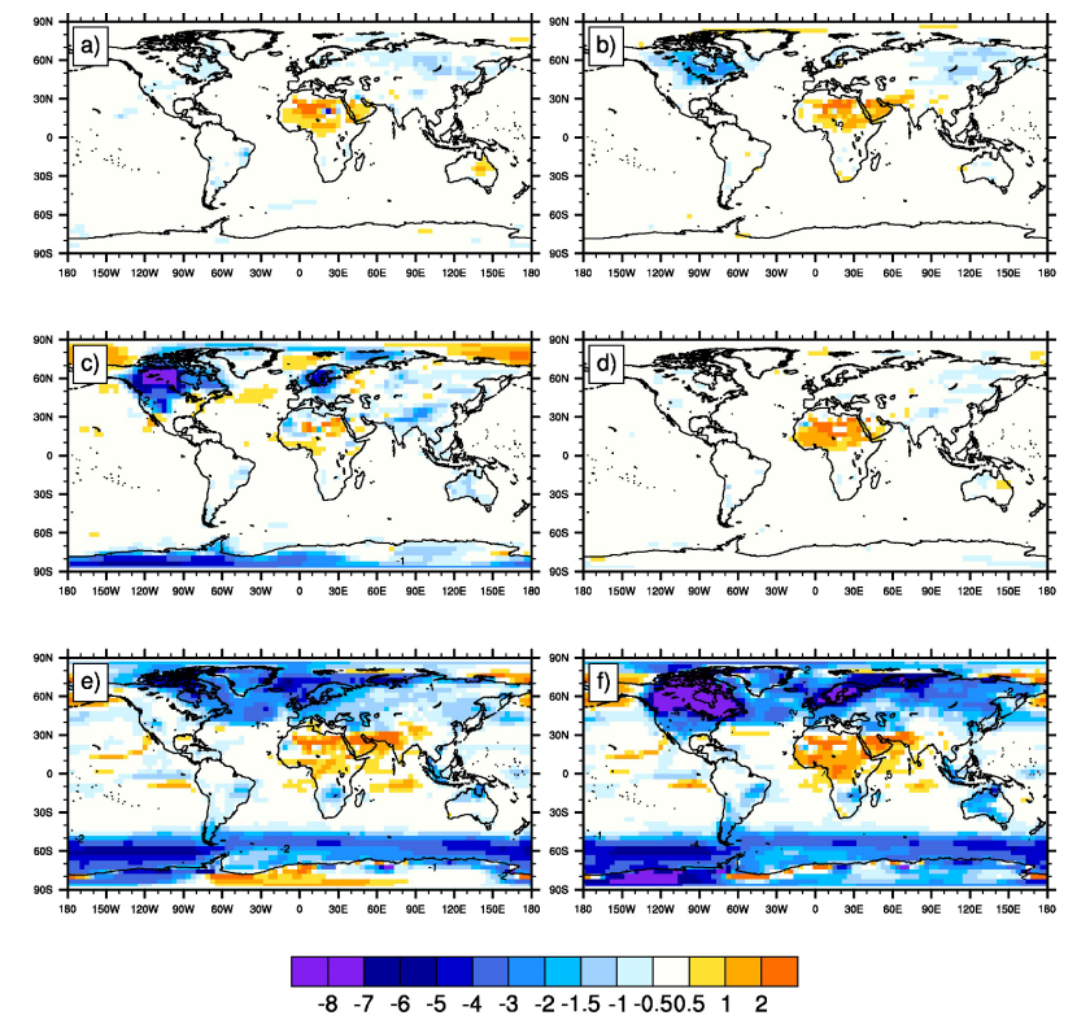
Fig. 4. Annual mean difference of δ 18 O precip (‰) of (a) GHG, (b) albedo, (c) topography, (d) orbital, (e) SST, and (f) LGM-combined experiments from the control